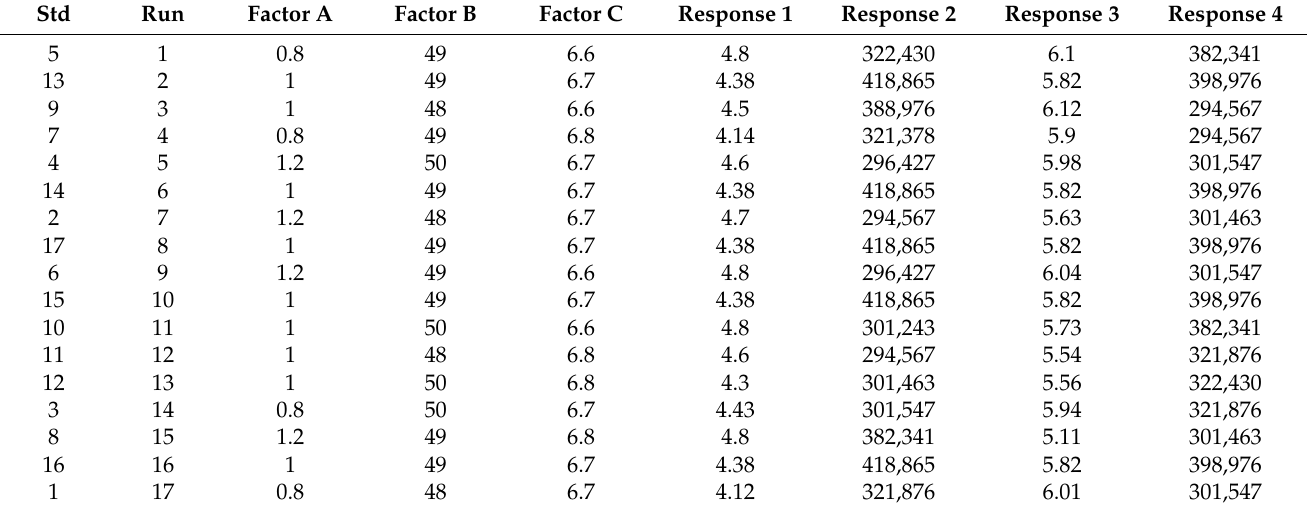
Table 1. Design summary.